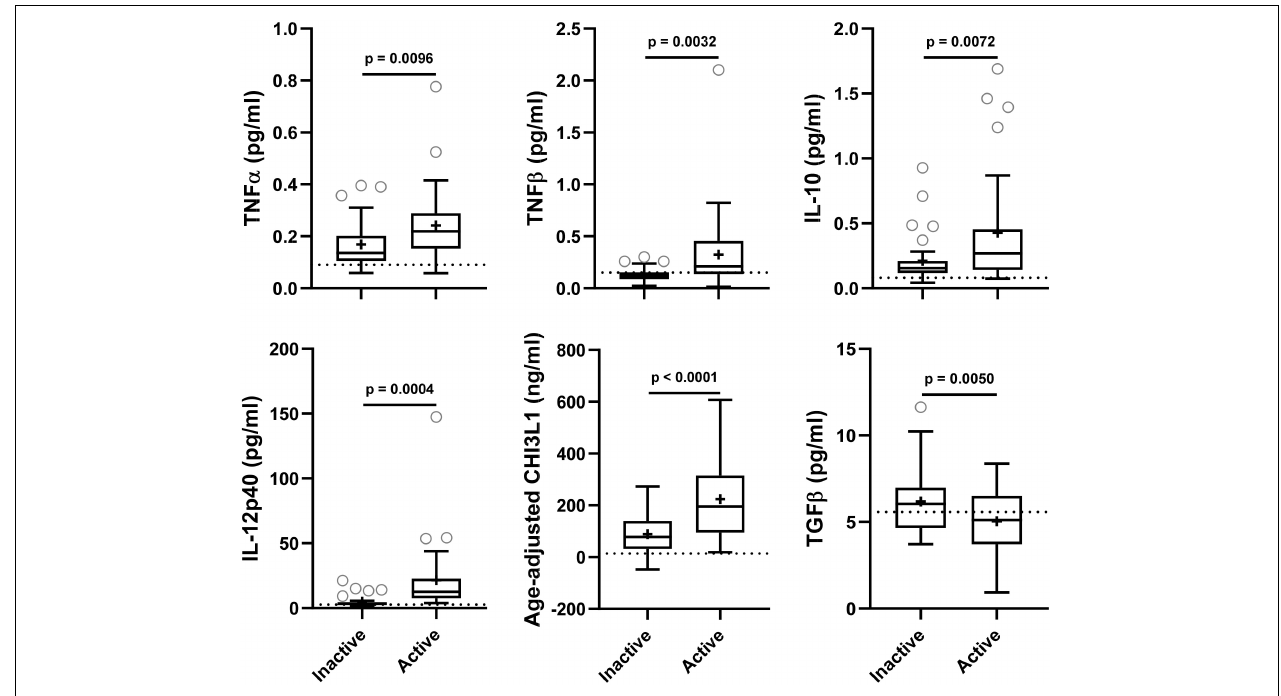
FIGURE 2 | In the training cohort, biomarker concentrations were compared across lesional activity subgroups (inactive versus active, n = 35 each subgroup). Dotted line represents median of HDs and “+” sign represents mean of respective subgroup. Data only for biomarkers which are statistically significantly different ( p < 0.01; unpaired t -test) between two subgroups is depicted